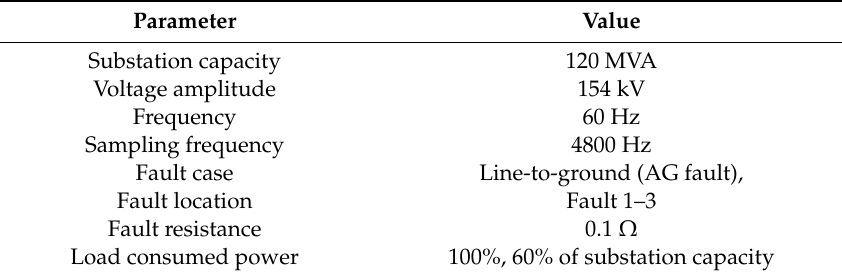
Table 3. Parameters used in computer simulation.